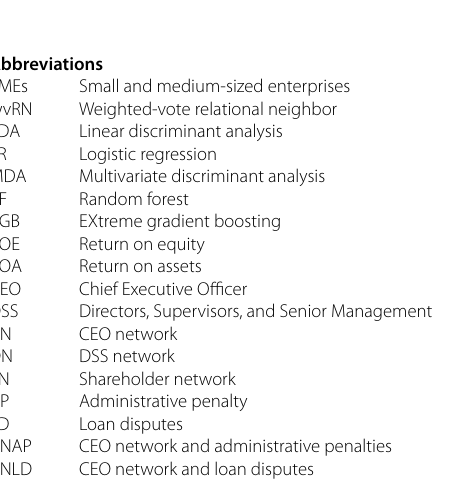
Each metric is measured by the mean of 100 estimates obtained by repeating the outer ten-fold cross-validation procedure ten times